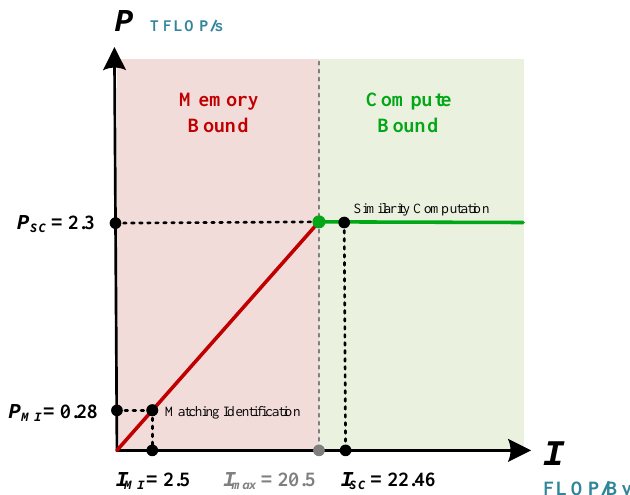
Figure 11. Roofline model for NVIDIA GeForce GTX 960 GPU with two stages of PSOM: similarity computation stage and the matching identification stage.